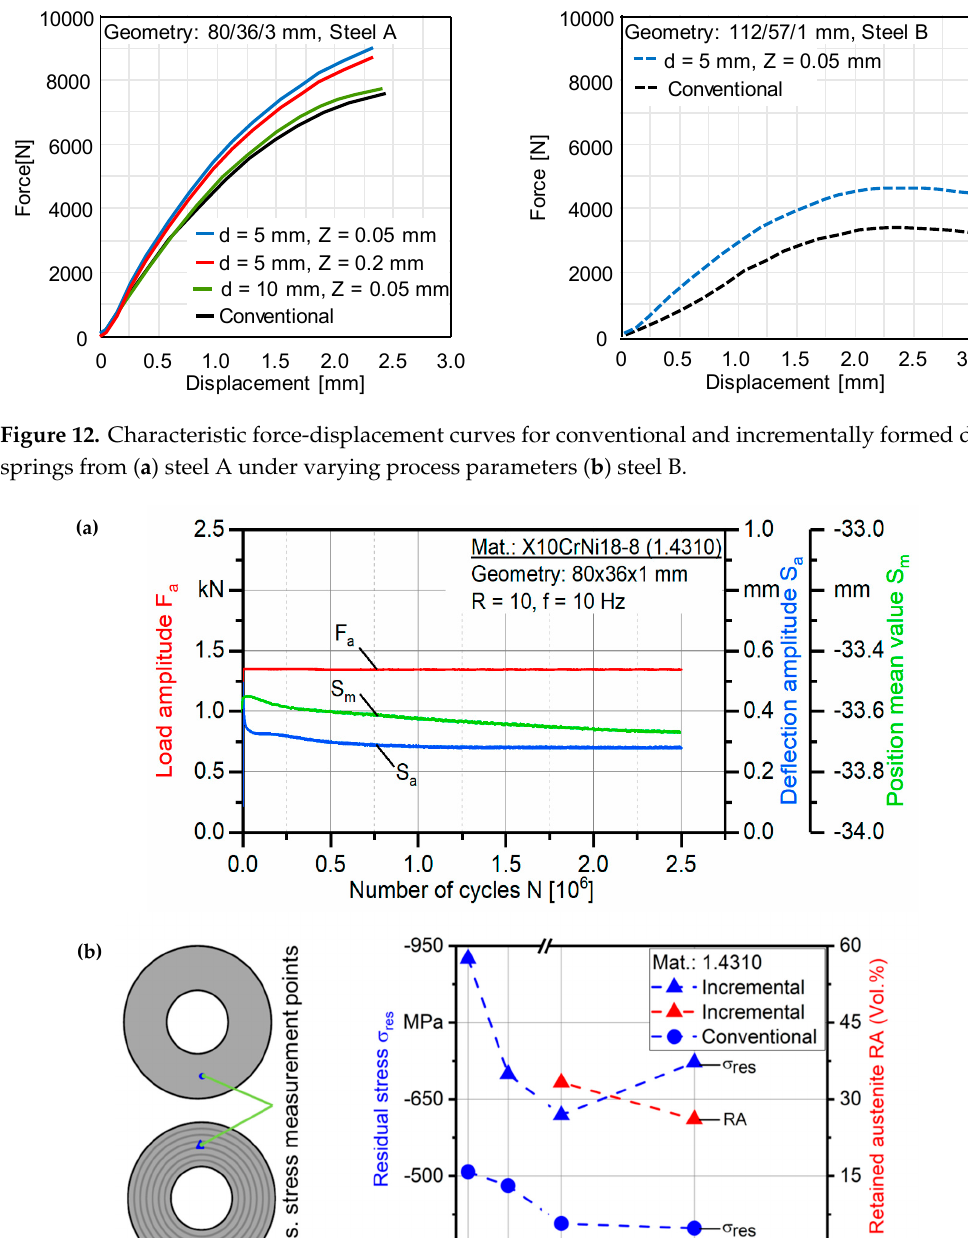
12 of 19 Figure 11. Repeatability of the residual stresses measured by X-ray diffraction (XRD) in conventional and incrementally formed disc springs from steel B under the same set of process parameters. 4.2. Quasi-Static and Cyclic Response